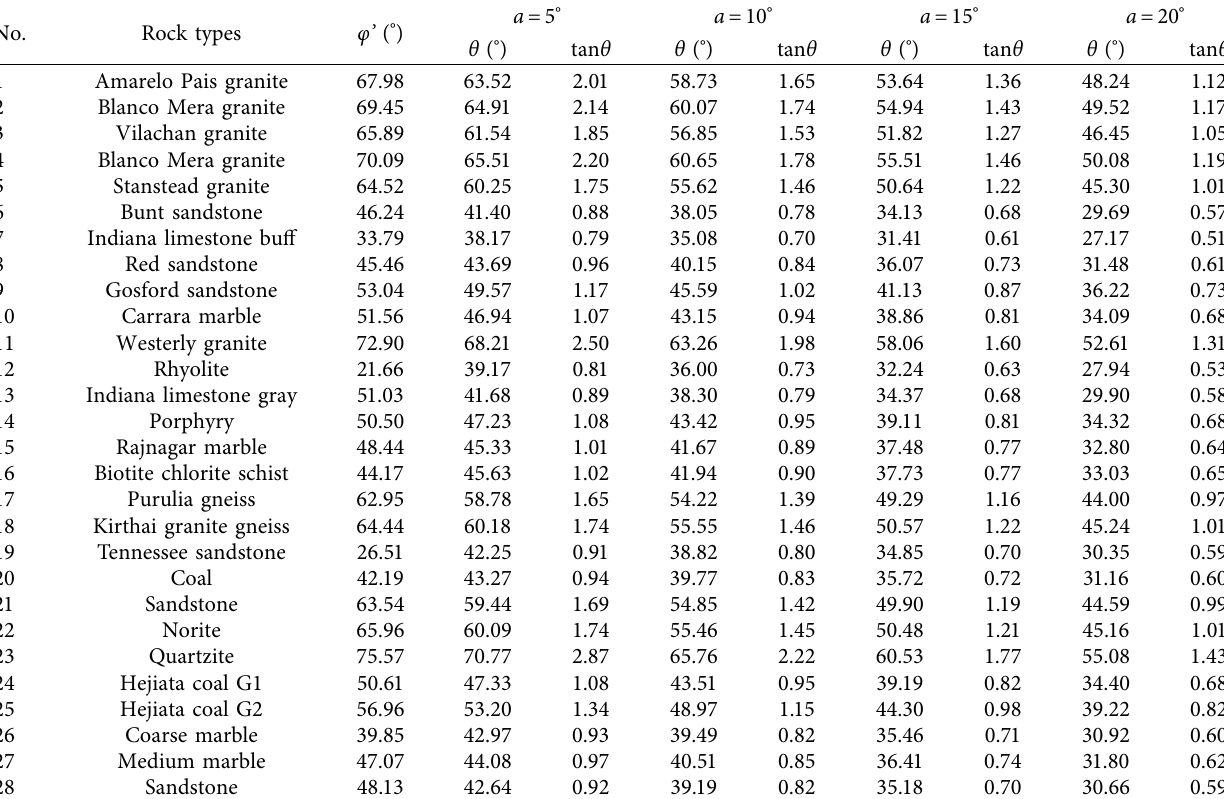
Table 2: Summary of the calculated contact friction coefficient at the different rake